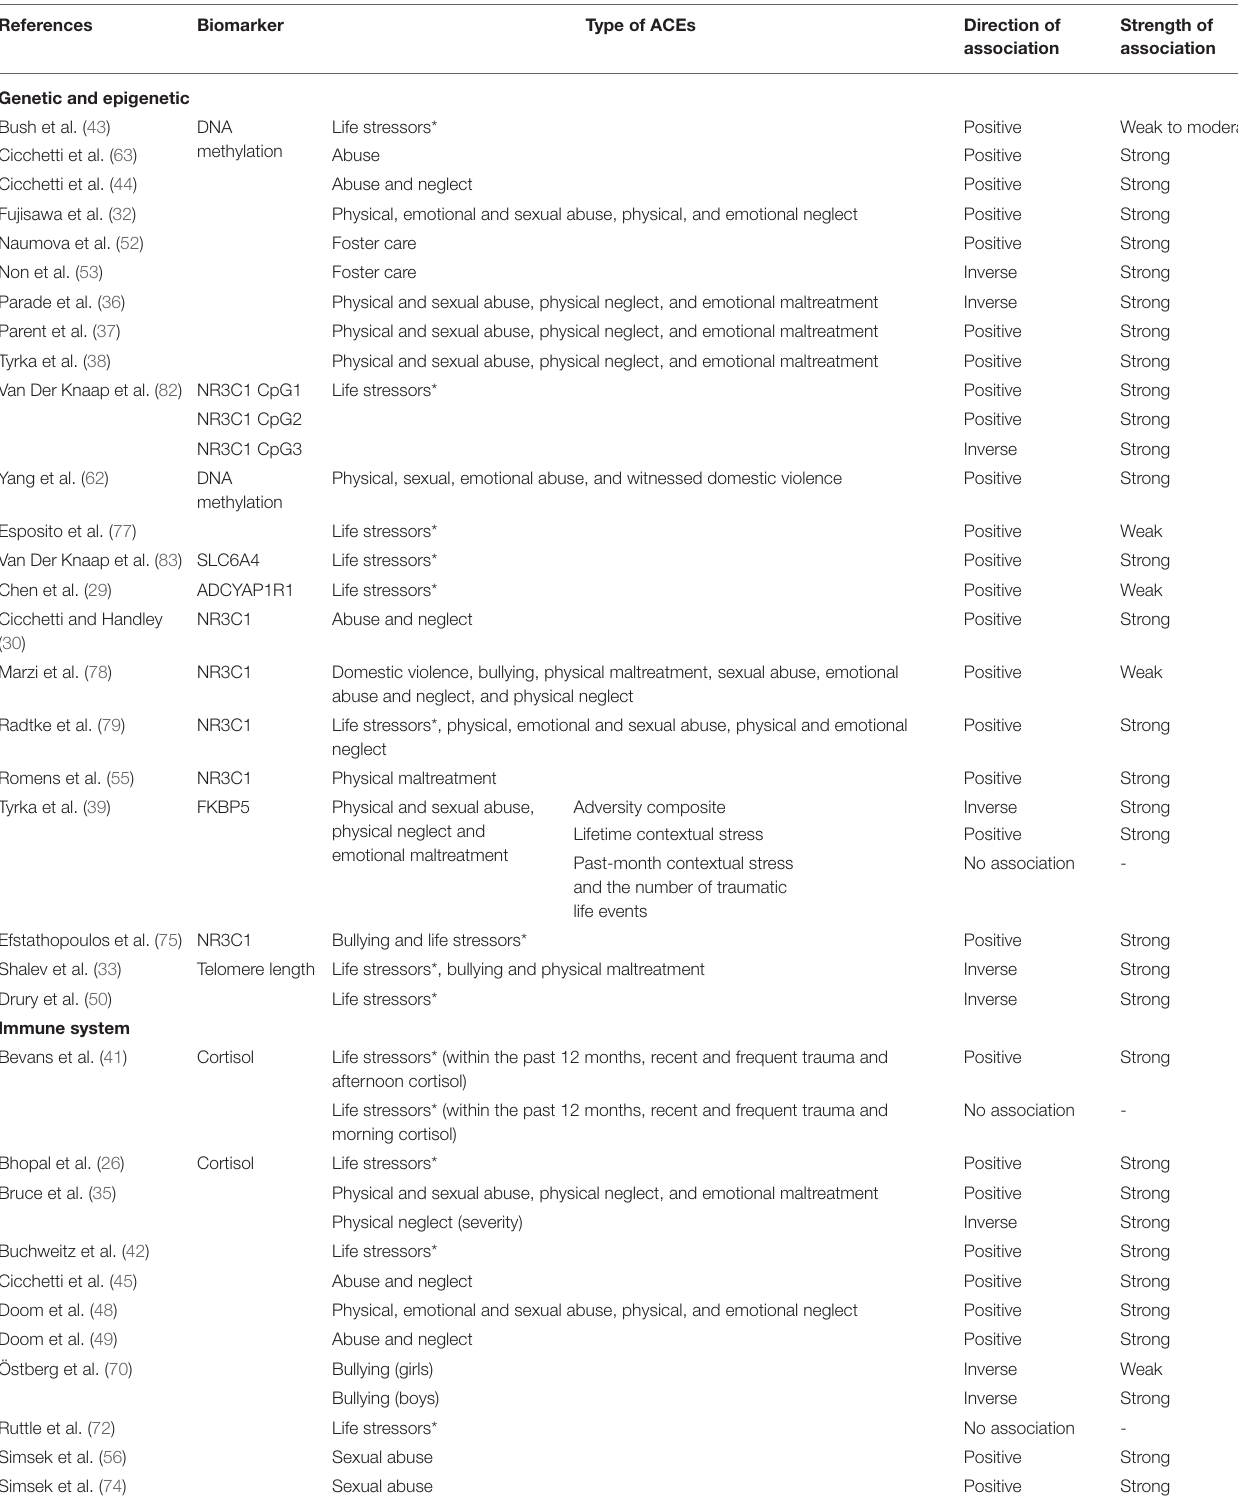
TABLE 4 | Direction and strength of association between exposure to ACEs and biomarker by biological mechanism (positive associations indicate that biomarker increases with ACEs exposure and/or frequency; inverse associations indicate that biomarker decreases with ACEs exposure and/or